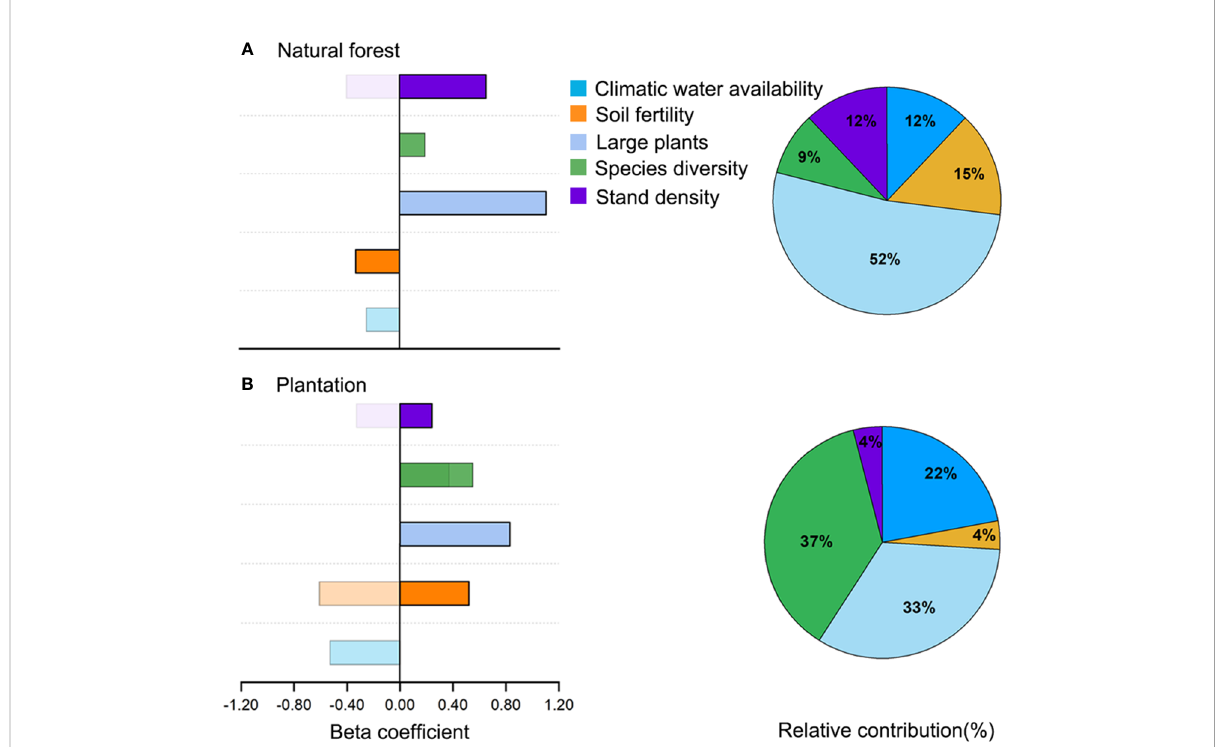
FIGURE 4 Total relative contribution ( A ; pie charts) of predictors to aboveground biomass and comparison of direct and indirect effects ( B ; bar charts) of predictors on aboveground biomass in natural forest and plantation. Solid- fi lled color represents direct effect, whereas pattern- fi lled color represents indirect